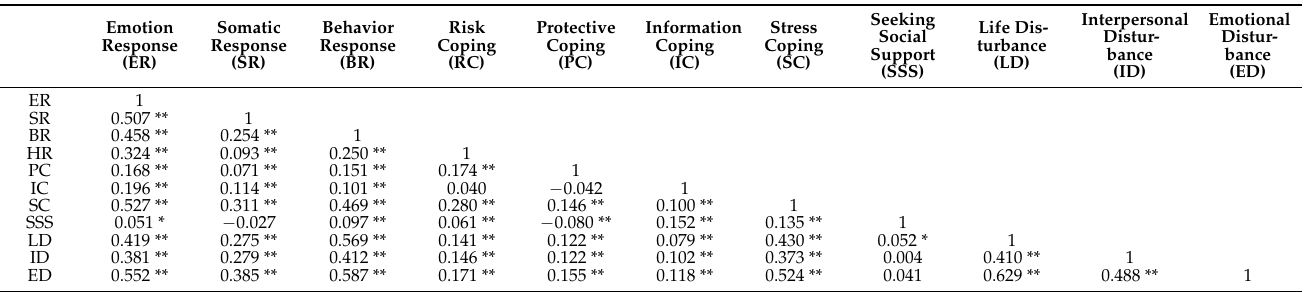
Table 2. Correlation matrix between dimensions of the questionnaire ( n =